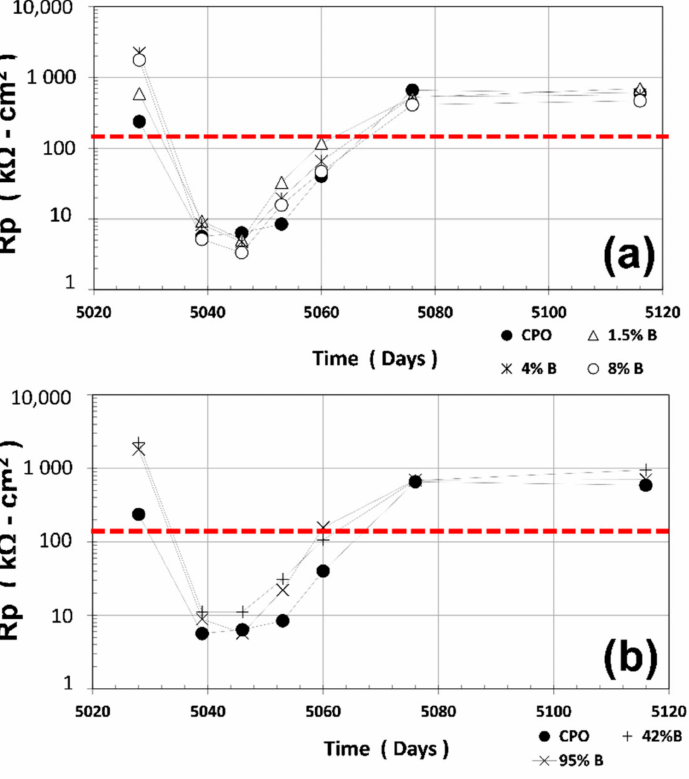
Figure 2. Average polarization resistance (R P ) vs. time: ( a ) control vs. low OFI mucilage concentra- tion; ( b ) control vs. high OFI mucilage